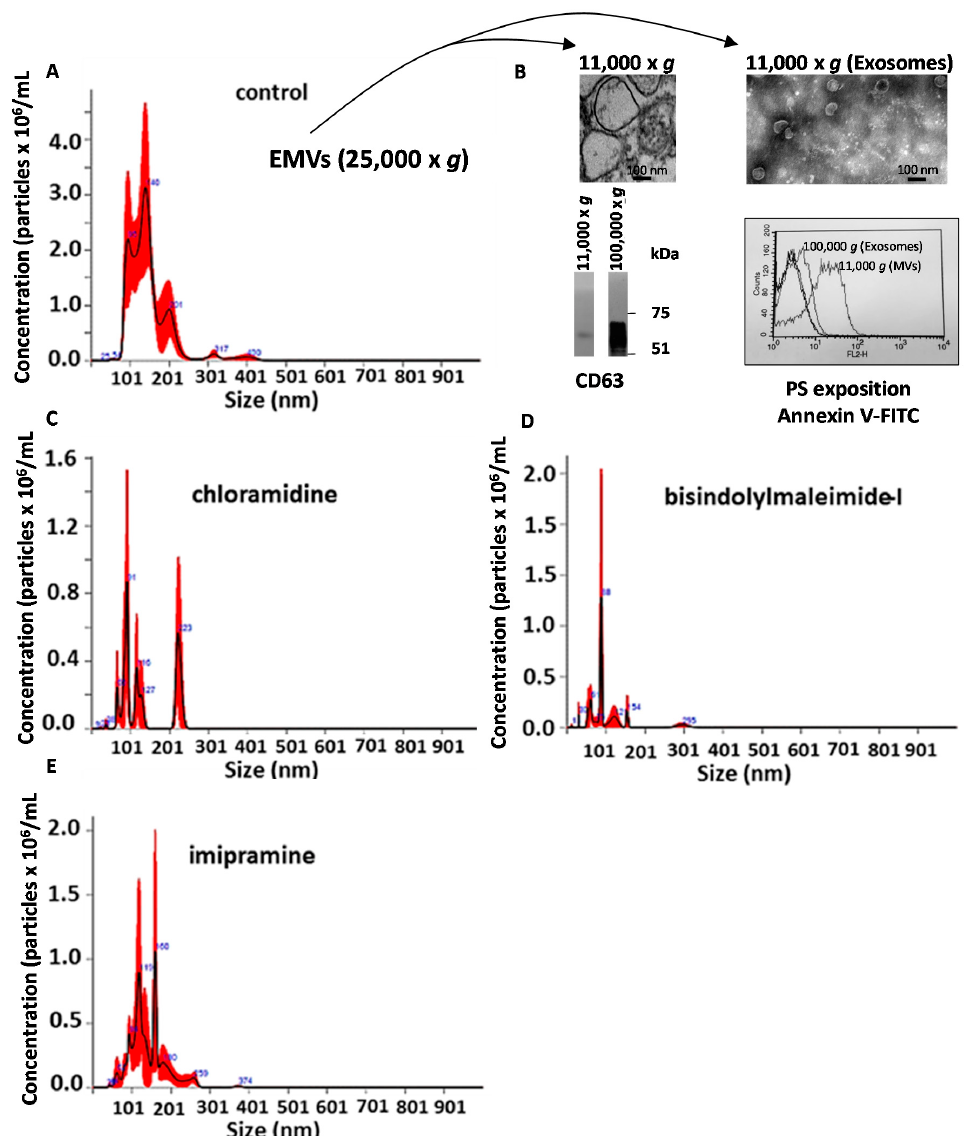
Figure 1. Nanoparticle tracking analysis (NTA) of exosomes and microvesicles (EMVs) released from PC3 cells in the presence of a range of EMV inhibitors. Plots presenting NTA analysis show the concentration of vesicles (0–900 nm in diameter) released from PC3 cells in the absence of any EMV inhibitors ( A ); In ( B ) the EMVs are shown to comprise exosomes and microvesicles (MVs) by electron microscopy, by Western blotting (for CD63 expression), and by the degree of phosphatidylserine (PS) exposition. NTA analysis for released EMVs from PC3 cells are presented in the presence of Cl-amidine ( C ); bisindolylmaleimide-I ( D ); and imipramine ( E ). Vesicles outside the size range of 0–900 nm were excluded to avoid including larger vesicles such as MV aggregates or apoptotic bodies. The experiment was repeated three times in total (error bars ± SEM, indicated in red).